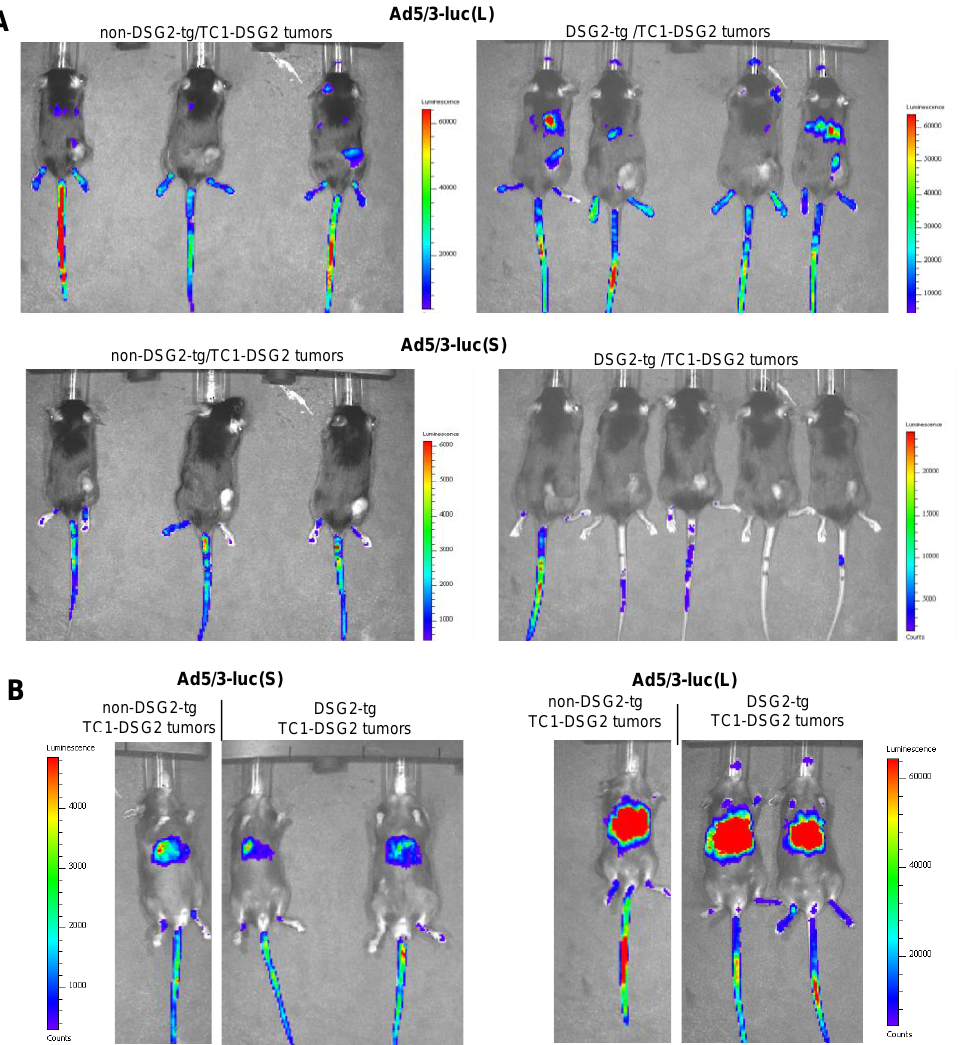
Figure 6. In vivo imaging for luciferase expression after intravenous Ad5/3 injection. ( A ) Images taken from the back of mice on day 3 after virus injection. Shown are three non-DSG2-tg/TC1-DSG2 tumors and four DSG2-tg/TC1-DSG2 tumor mice injected with Ad5/3-luc(L) or Ad5/3-luc(S). Tumors are visible at the lower right back side. Strong signals at the injection site (tail veins) are noted. The exposure time was 180 s. ( B ) Images taken from the front of mice.